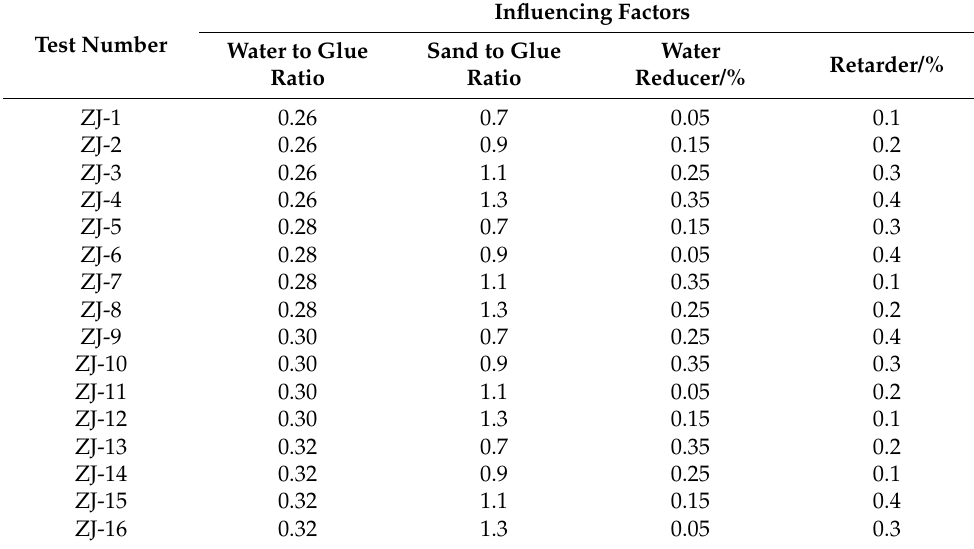
Table 6. Result of the orthogonal